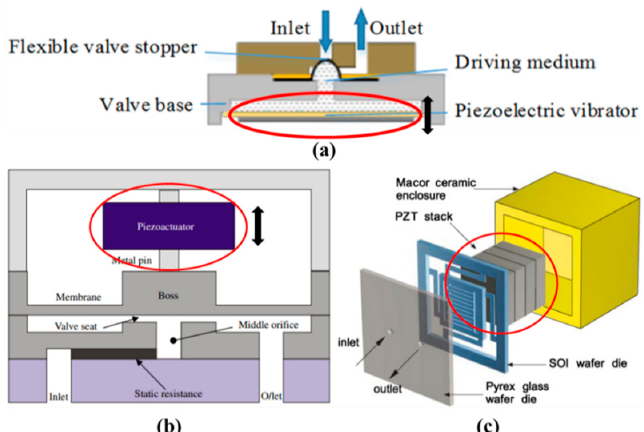
Figure 4. Typical structures of piezoelectric microvalves: ( a ) a normally-closed piezoelectric microvalve with flexible stopper [40]; ( b ) a high pressure piezoelectric actuated microvalve [41]; ( c ) A piezoelectric microvalve for cryogenic applications [42].